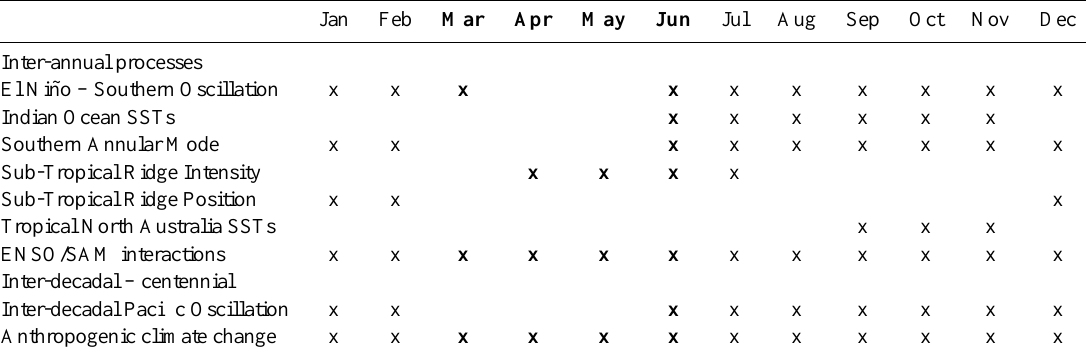
Table 1. The seasonality of the inter-annual and longer hydroclimate processes for the Murray-Darling Basin is identified. The “x” indicates the months in which previous studies (see Sect. 3) have reported an influence of the process stated in the left-half column on the Murray- Darling Basin’s climate. The months in bold (March, April, May, June) are those that experienced large and persistent rainfall deficits during the Big Dry (ca. 1997–2010).